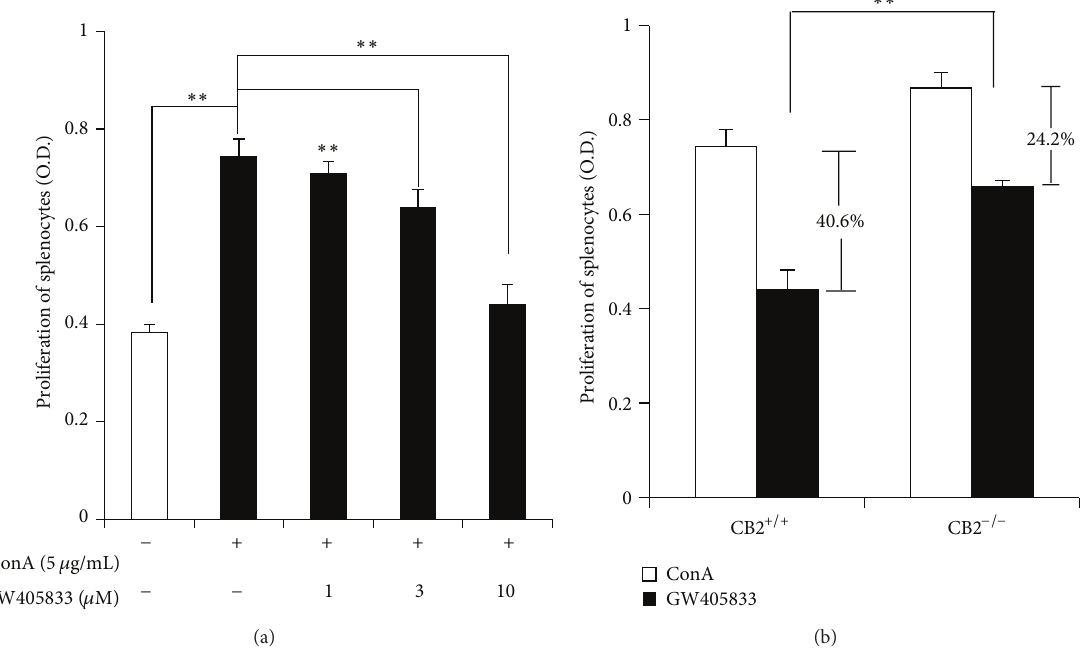
Figure 2: GW405833 inhibits ConA-induced splenocytes proliferation partially via CB2R activation. (a) Splenocytes isolated from CB2R +/+